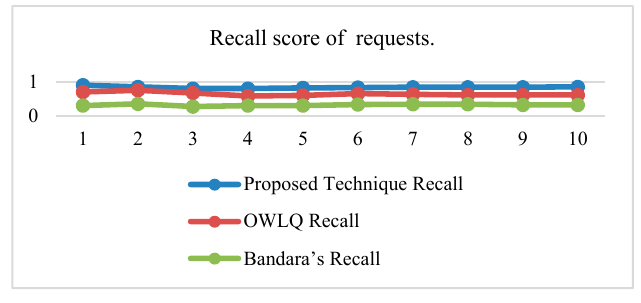
Figure 7. Recall score of services.